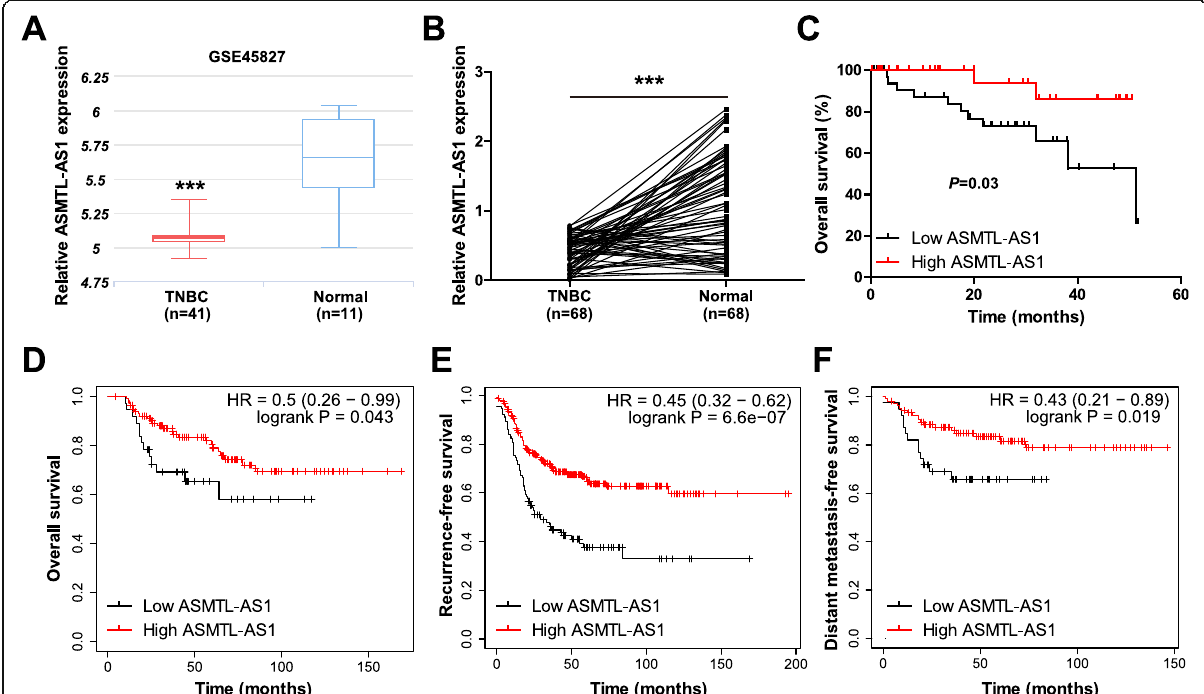
Fig. 1 ASMTL-AS1 is significantly decreased in TNBC. a The expression of ASMTL-AS1 in GSE45827 database. b qRT-PCR analysis of ASMTL-AS1 expression in 68 matched TNBC and normal tissues. c The overall survival curve of TNBC patients with low and high ASMTL-AS1 levels in our cohort. d - f . The overall, recurrence- or distant metastasis-free survival curve of TNBC patients with low and high ASMTL-AS1 levels in Kaplan-Meier plotter database. *** P <0.001. The high and low expression level of ASMTL-AS1 in this study was based on median ASMTL-AS1 level in TNBC